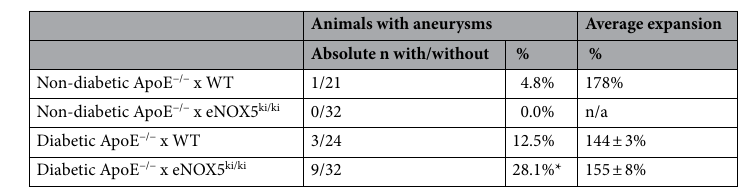
Table 3. Aneurysm formation in diabetic ApoE −/− x NOX5 ki/ki animals and their respective WT controls at 20 weeks of study. Data are expressed as the number of animals with aneurysms present, compared to the total number of animals assessed for aneurysm formation. Average % expansion as compared to normal vessel width measured above and below the aneurysm (where normal vessel = 100%); n for average expansion: nondiabetic ApoE −/− x WT = 1, Diabetic ApoE −/− x WT = 3, Diabetic ApoE −/− x eNOX5 ki/ki = 8. Overall significant in a non-parametric multiple comparison (Kruskal Wallis test). * p < 0.01 Diabetic ApoE −/− x eNOX5 ki/ki versus non-diabetic ApoE −/− x eNOX5 ki/ki